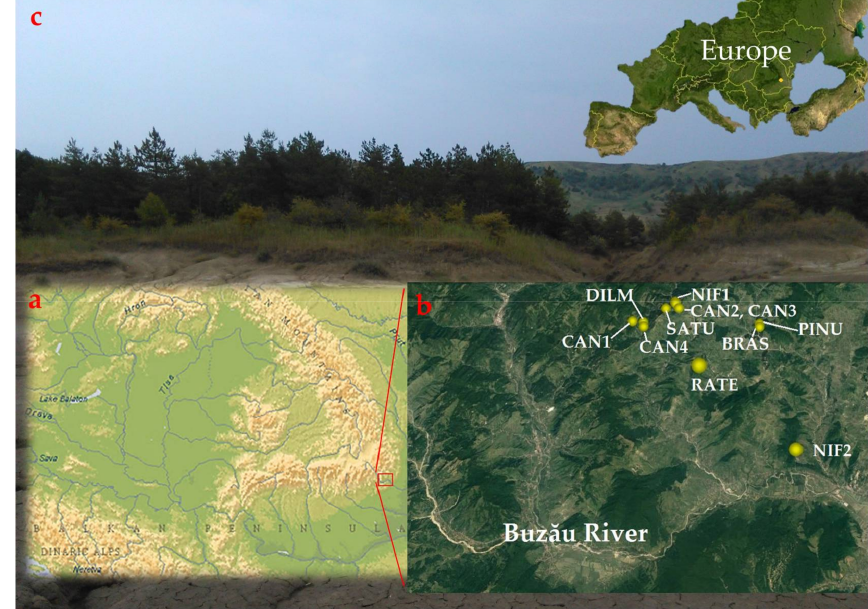
Figure 1. ( a ) Geographical location of the study area in the Carpathians area (South-eastern Europe); ( b ) Map of the sample plots area (the yellow dots mark the sampled stands); ( c ) A pine plantation on a Buzau’